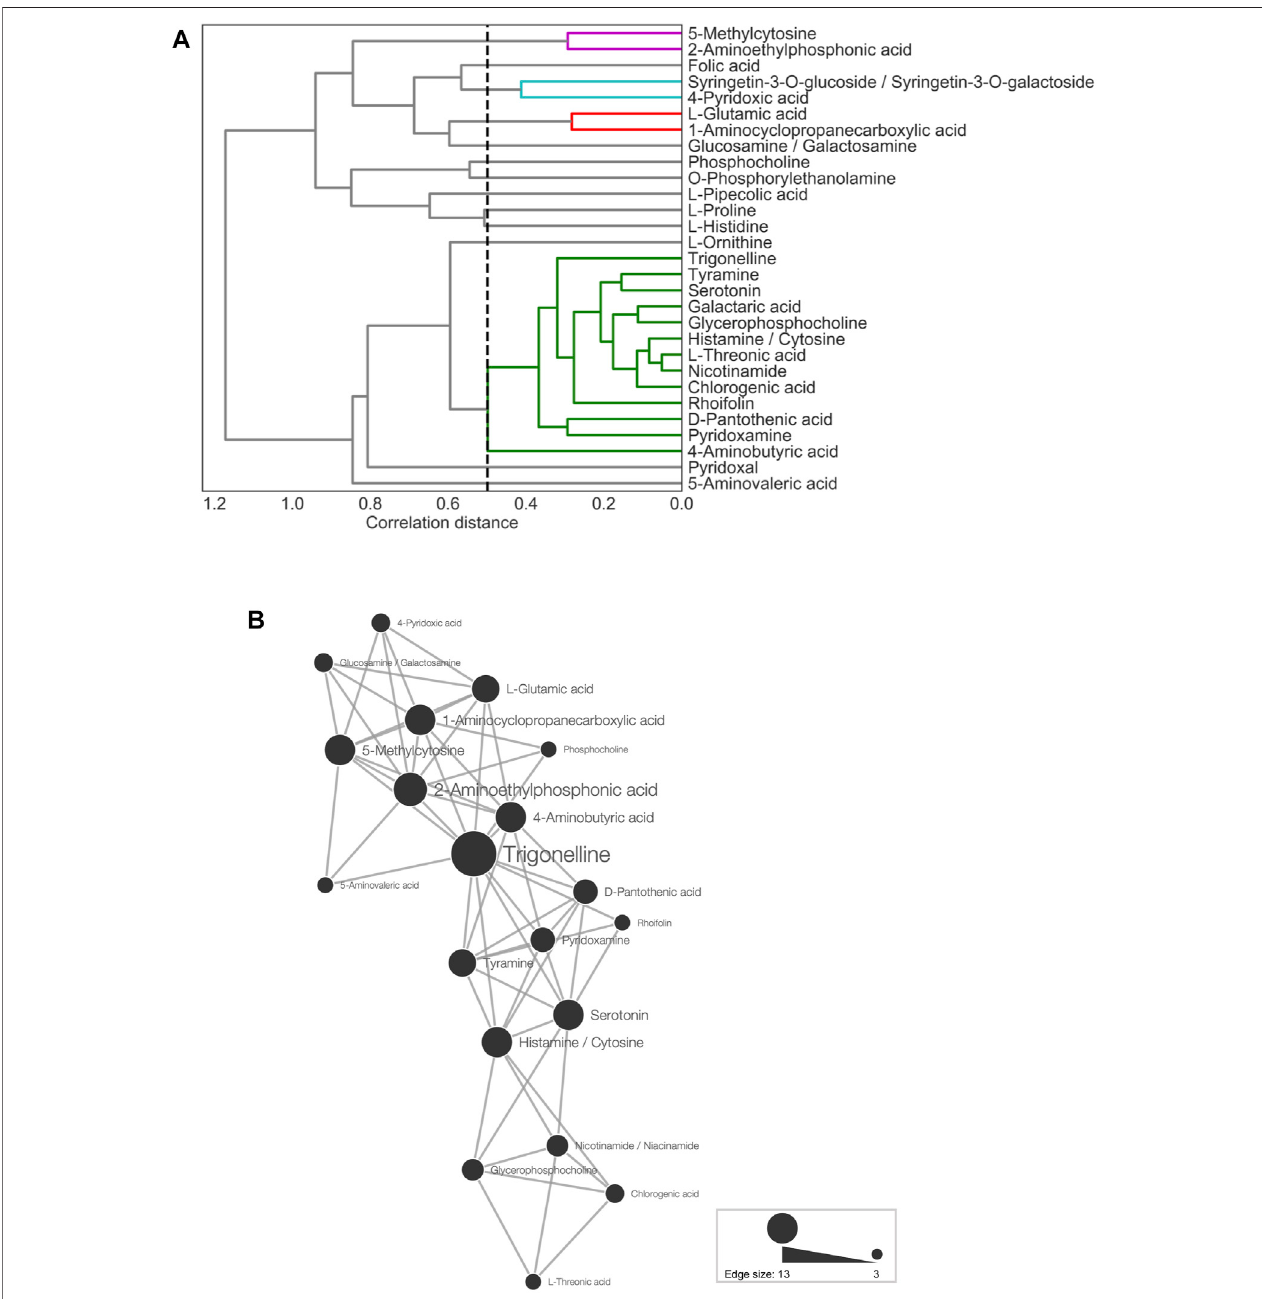
FIGURE 4 | Metabolite association of 29 predictor metabolites. (A) Dendrogram representing agglomerative clustering of the correlation distances of the 29 selected metabolites in average linkage. The cluster threshold was 0.5, as indicated by the black dotted line. Lines of the same color represent the same clusters. (B) Network for metabolites (threshold: ≤ 15th percentile of Euclidean distances). The node size represents the number of edges linked to other metabolites.